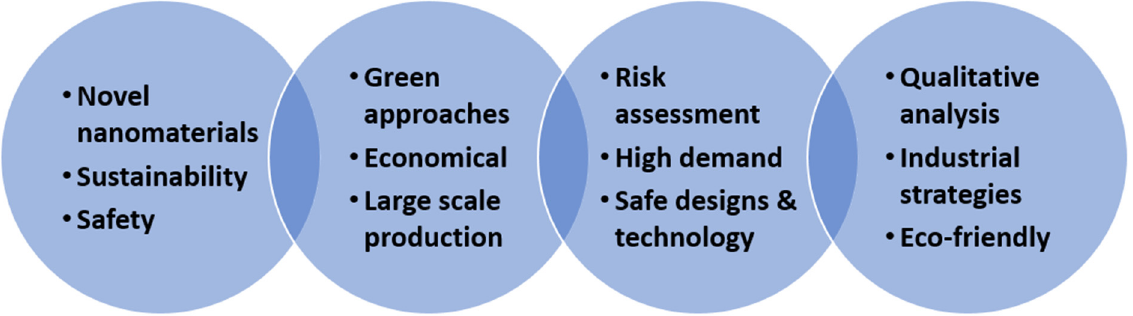
Figure 14. Strategies for future perspectives.